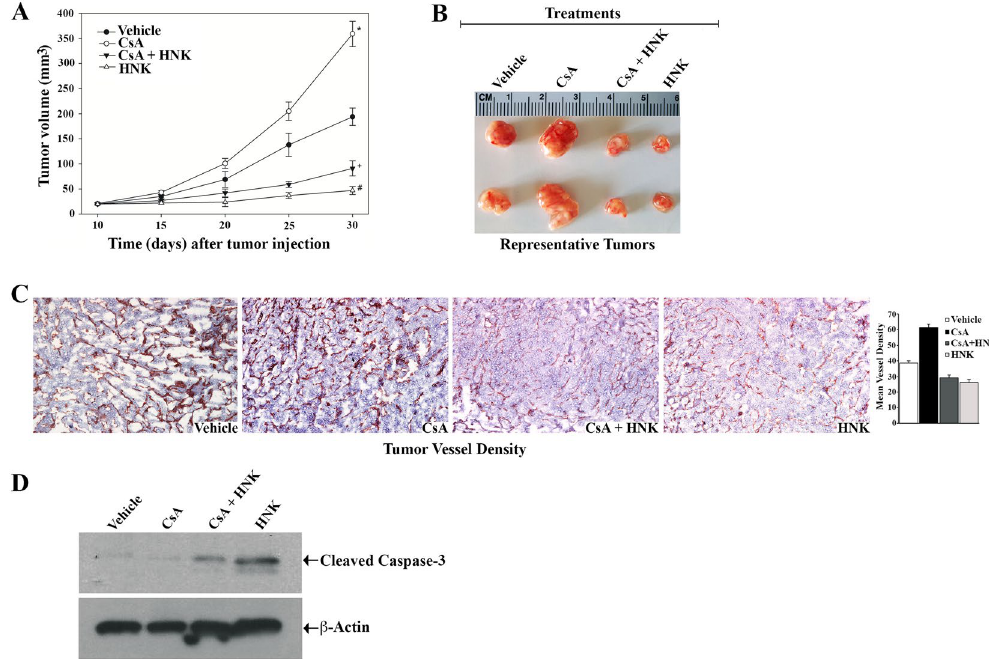
Figure 5. HNK treatment inhibits CNI-induced renal tumor growth in vivo ; and it is associated with decreased tumor vasculature and increased tumor cell apoptosis. Nude mice were subcutaneously, xenografted with 786-O cells (1 × 10 6 ), and when palpable tumor appeared around 10 days later, mice (n = 5 each group) were treated intraperitonealy with different combinations of CsA (10 mg/Kg/day) and HNK (2 mg/Kg/day); and the mice in control group were treated with vehicle alone. Treatments were continued for up to 20 days (i.e. 30 days after tumor injection). ( A ) Tumor volumes were calculated (as described in “Materials and Methods” section) for the four treatment groups. The mean change in tumor volume is shown in the tumor growth curve, ( * CsA compared to vehicle treatment, p < 0.0001; + (CsA + HNK) treatment compared to CsA alone, p < 0.0001; and #, HNK alone compared to (CsA + HNK) treatment, p < 0.0001). The data reflect representative of two independent experiments. ( B ) Tumors were excised after euthanizing mice at the end of study, and two representative tumors from each group is shown to depict tumor size. ( C ) IHC stains showing the expression of CD31 in harvested tumor tissues of mice from all treatment groups. Representative photomicrographs (magnification, x400) of tissue sections from each treatment group are shown. Side panel , bar diagram depicts mean vessel density calculated by standard grid counting of CD31-positive vessels. The data reflect ± S.D. of three different tissues from each group, in which three to four non-overlapping fields of each specimen were analyzed in a blinded manner. ( D ) Total tissue lysates, prepared from the excised tumors, were utilized to measure the expression level of cleaved caspase-3 and β -actin by Western blot. The bands from adjacent lanes were cropped from the same blot (full-length blots are included in a supplementary file). Representative blots of three different tumor tissue lysates from each group are